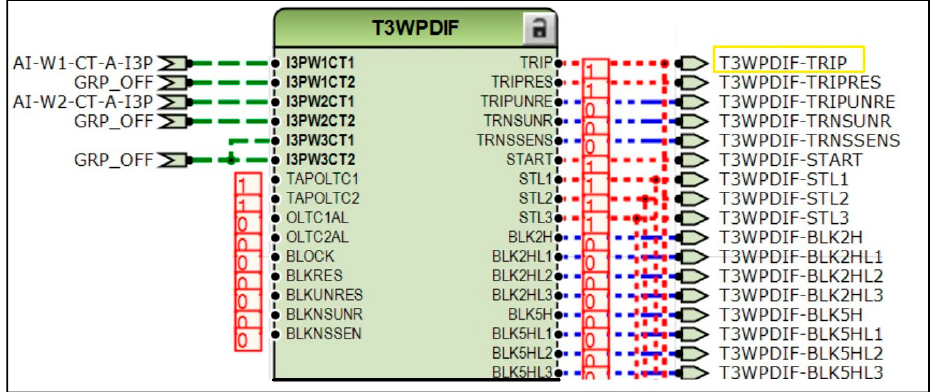
Figure 7. Measured protection operation by relay logic software ABB-PCM 600 [17].